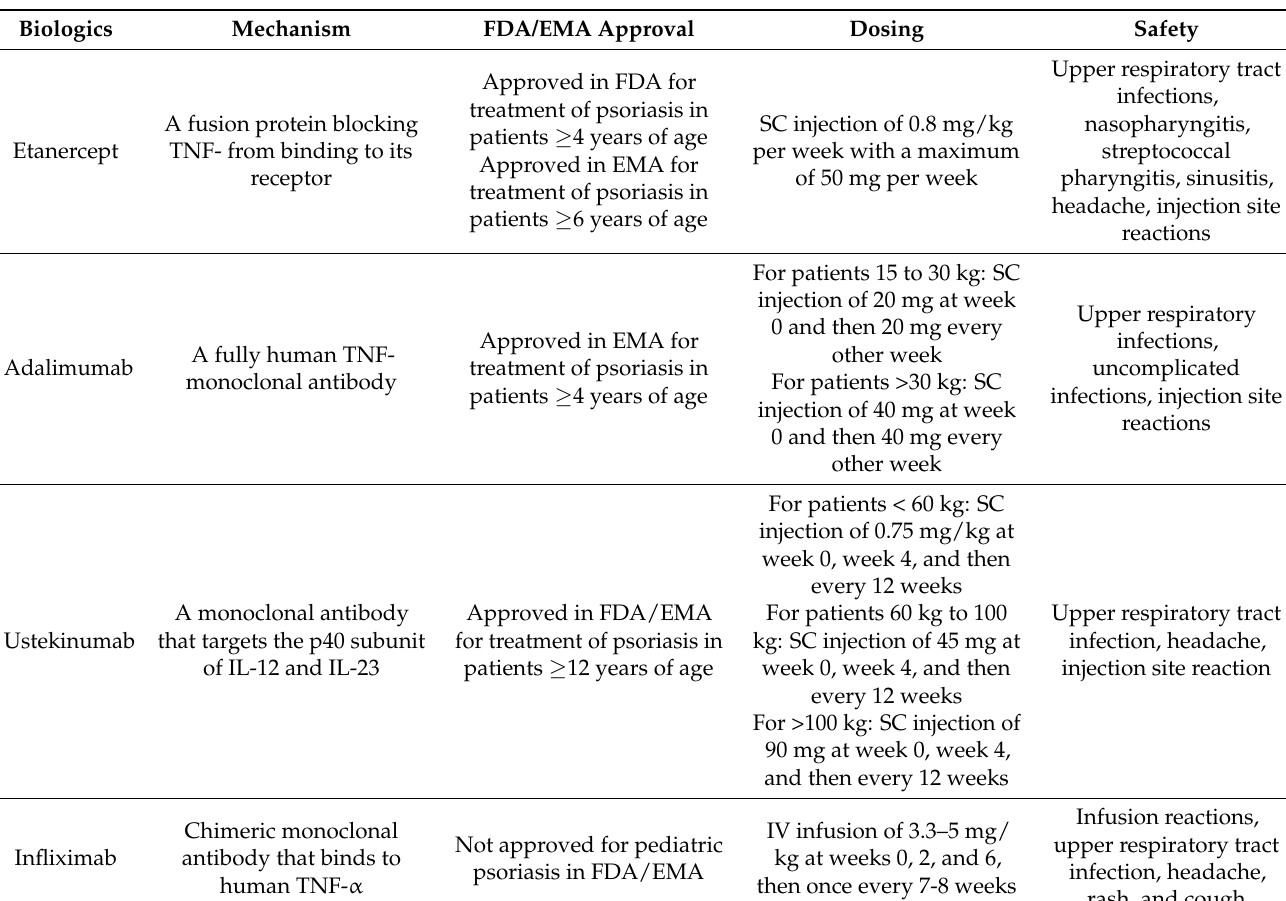
Table 2. Biologics for pediatric